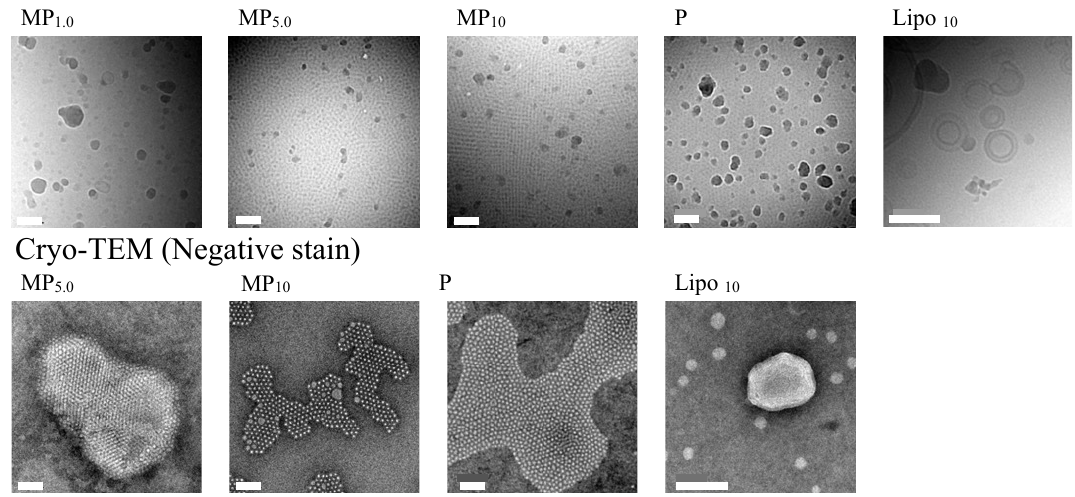
Figure 4. Cryo-TEM and negative-stained cryo-TEM observation results. The white bar indicates 100 nm.